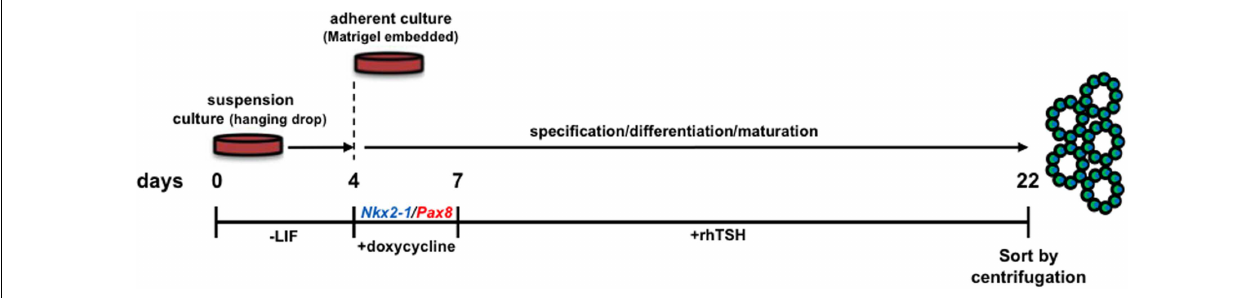
FIGURE 1 | Schematic diagram of the protocol used for in vitro differentiation of thyroid follicles from a tetracycline-inducible murine Nkx2-1-Pax8 ESC line . LIF, leukemia inhibitory factor; rhTSH, recombinant human thyroid stimulating hormone. Initial culturing of ESCs in hanging drops (without LIF supplementation) allows for embryoid body differentiation. Nkx2-1 and Pax8 are temporally induced by doxycycline, thereby directing